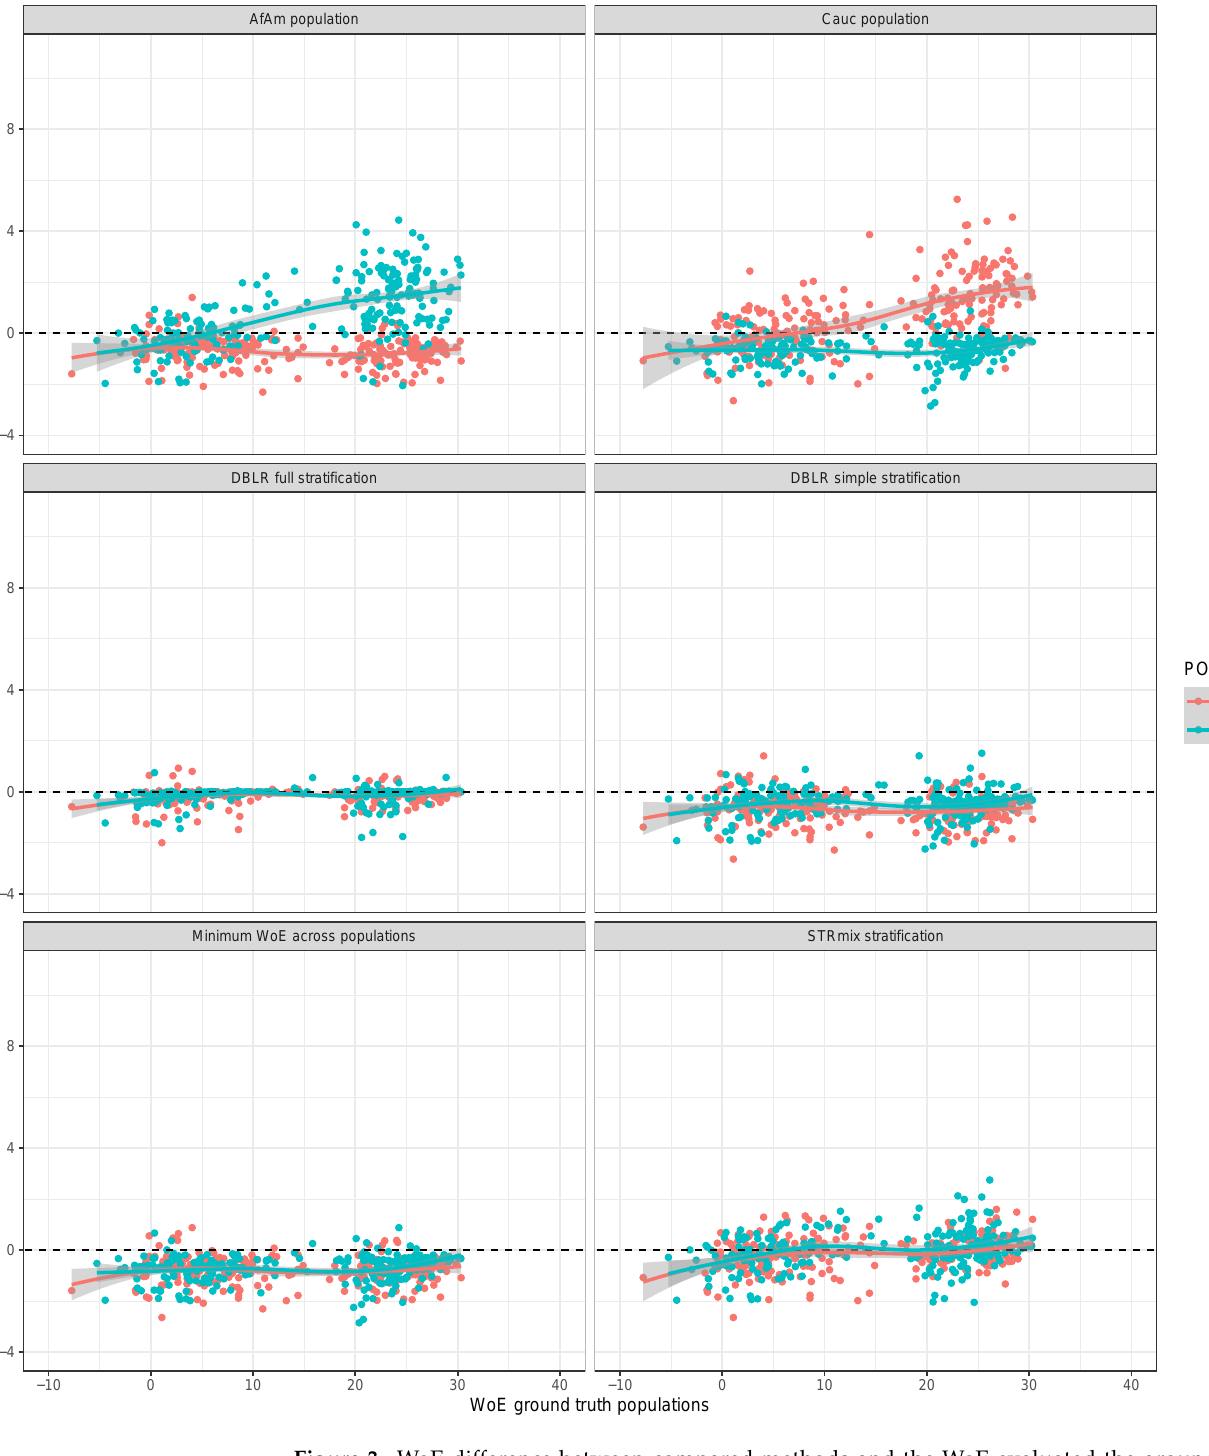
Figure 3. WoE difference between compared methods and the WoE evaluated the ground truth populations with F ST = 0.01 for the 500 donors to the 250 simulated two-person mixtures with contributors from different